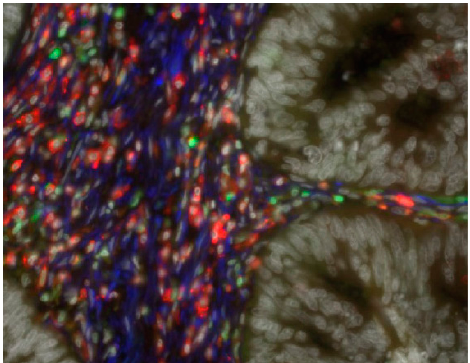
Figure 1. Distribution of cell types within a typical human colon tumor. Colors indicate respectively malignant epithelial cells (gray), immune cells (CD45, red), fibroblasts (fibroblast activation protein, blue), and endothelial cells (CD31, green), as stained in a multiplex analysis using a 40× field. Adapted from Sandberg et al. with permission [25].